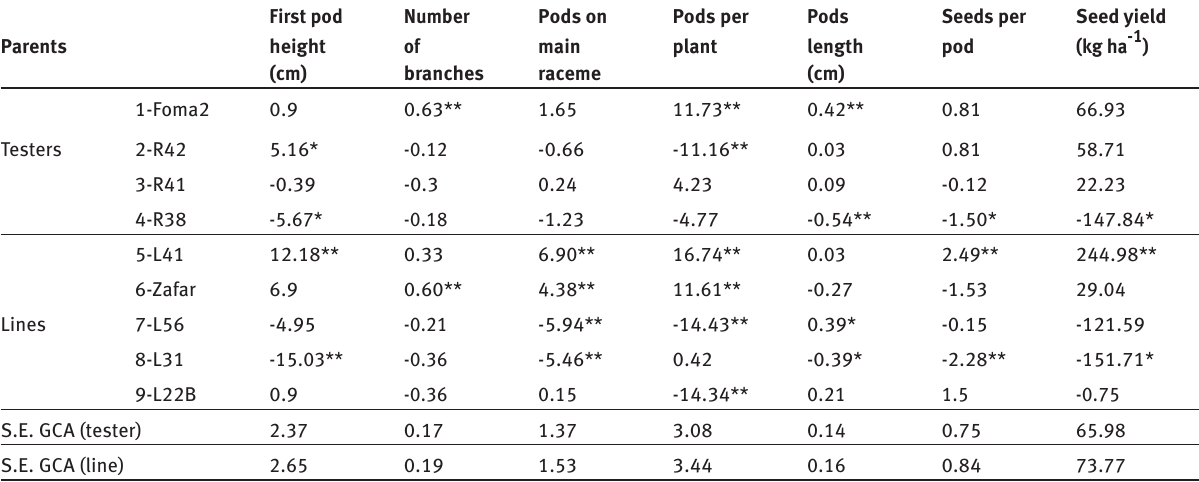
Table 3: Estimates of GCA effects for yield components and seed yield and oil of rapeseed ( Brassica napus L.) genotypes based on line×tester fashion